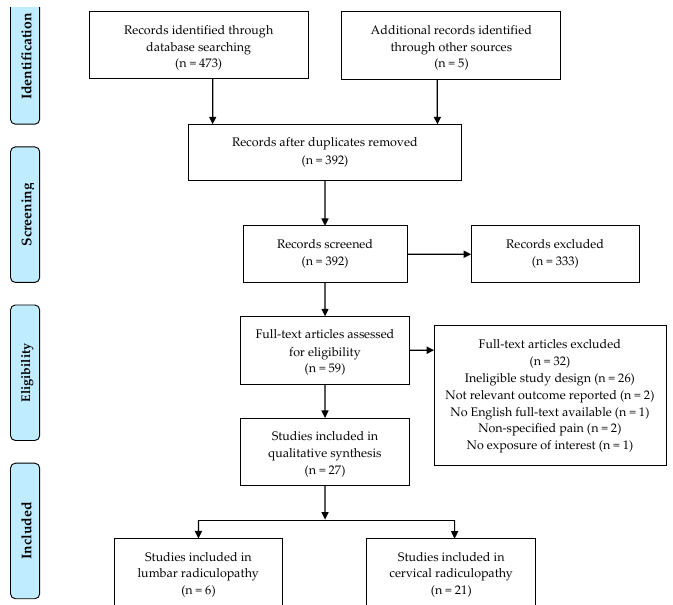
Figure 1. Study selection flowchart, according to PRISMA guidelines.